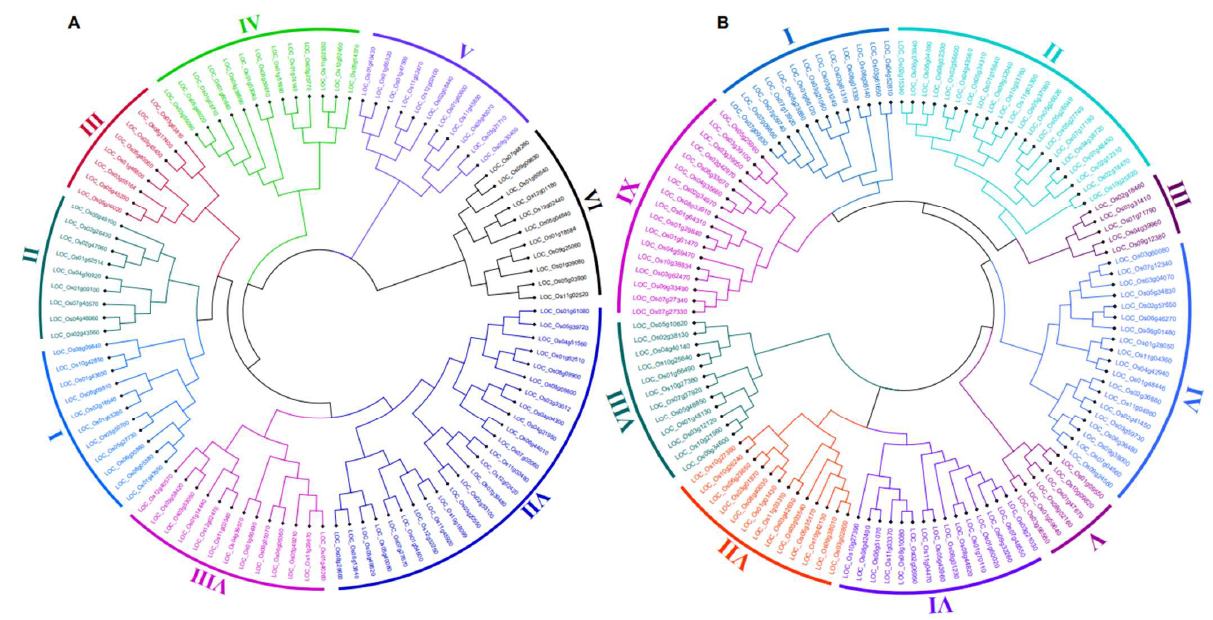
Figure 1. ( A ) The phylogenetic tree of 101 Oryza sativa WRKY TFs constructed via the NJ method using MEGA-11 software with 1000 bootstrap replicates. The major eight phylogenetic groups are marked as Ⅰ to Ⅷ , respectively. ( B ) The phylogenetic tree of 121 Oryza sativa NAC TFs constructed via the NJ method using MEGA-11 software with 1000 bootstrap replicates. The major nine phylogenetic groups are marked as Ⅰ to Ⅸ , respectively.